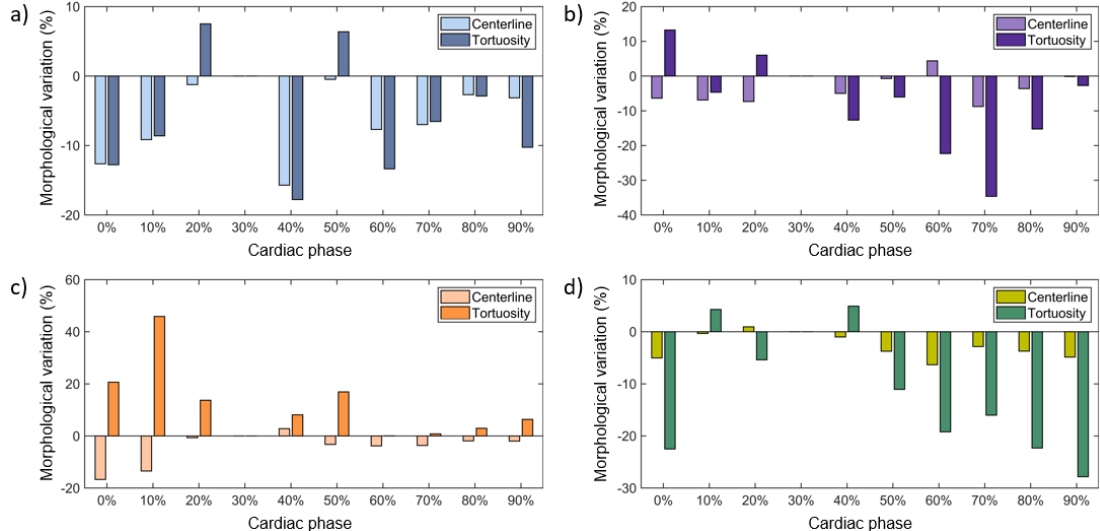
Figure 10. Variation of centerline and tortuosity indices at each phase of cardiac cycle for CW ( a ), CF ( b ), WS ( c ) and CS ( d ) shapes with respect to the systolic phase